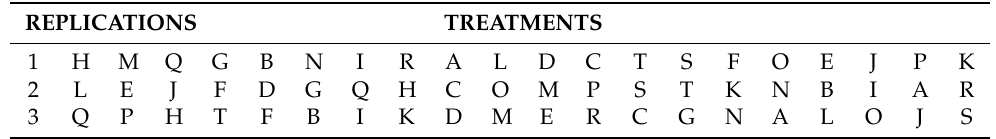
Figure 7. Examples of tag orientations at 6.0 m for M, N, O, and P. ( a ) M at upwards ( b ) N at downwards ( c ) O at Sideways Left ( d ) P at Sideways Right. Table 4. The treatment design for laboratory experiment.